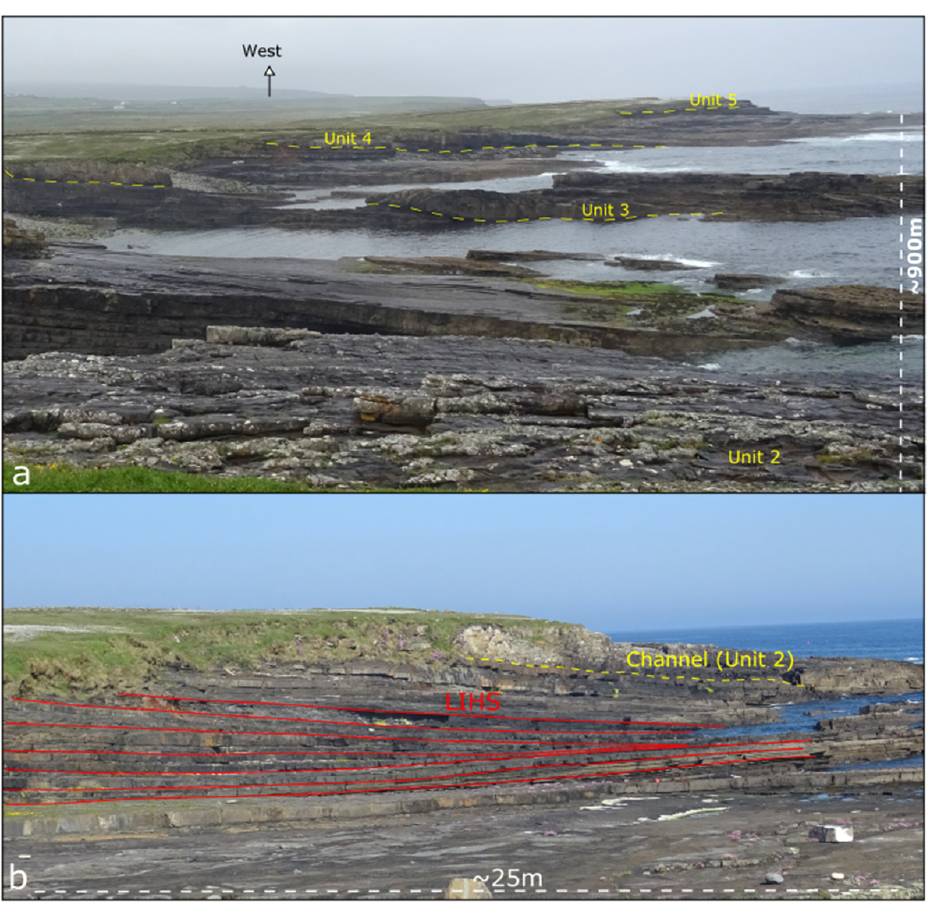
Figure 4. Facies architecture in the Mullaghmore Sandstone Formation at Ballycastle. ( a ) Field photograph taken standing on unit 2, looking broadly showing the position of several channel sandstone units; the bases of these units are indicated with dashed yellow lines. ( b ) Large inclined heterolithic surface (LIHS) below channel sandstone unit 2 (compare with +13 m to +16 m interval on log in Figure 3).